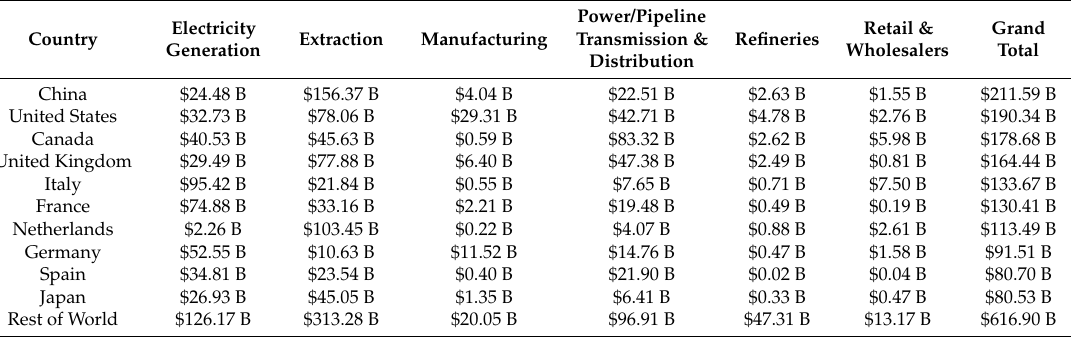
Table 4. Mergers & Acquisitions by energy supply chain segment.